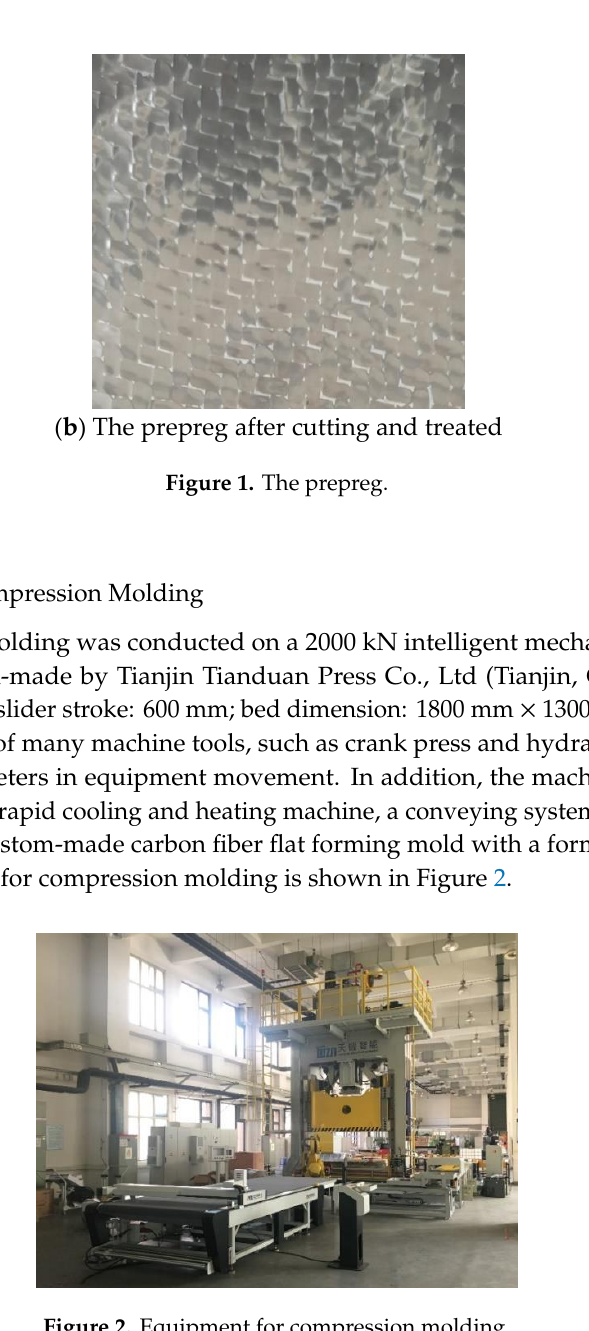
Figure 2. Equipment for compression molding.